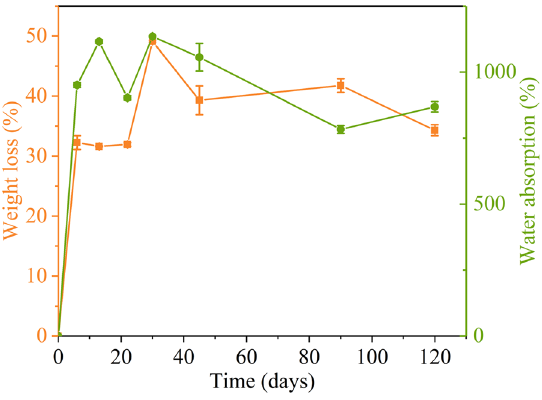
Figure 1: Weight loss and water absorption of modi fi ed PVA1788 in natural